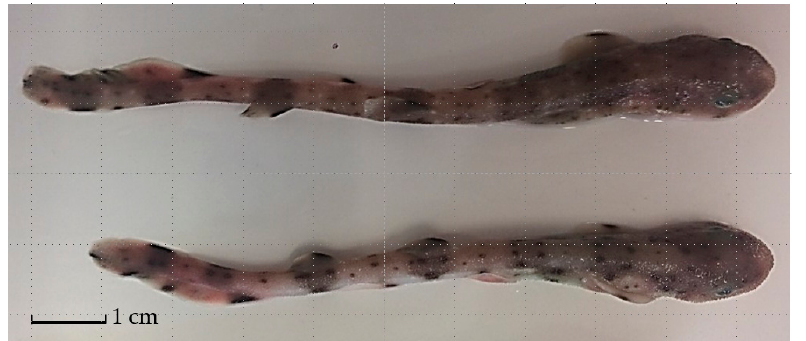
Figure 1. Specimens of lesser ‐ spotted dogfish ( Scyliorhinus canicula ) analyzed during this survey.